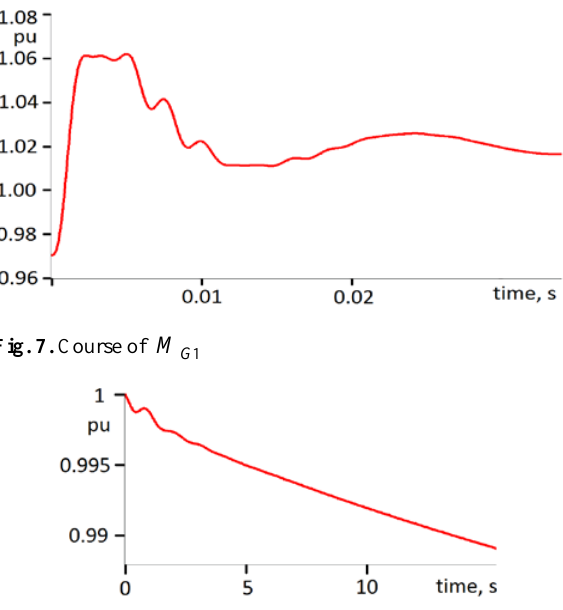
Fig. 8. Course of 1 G ω